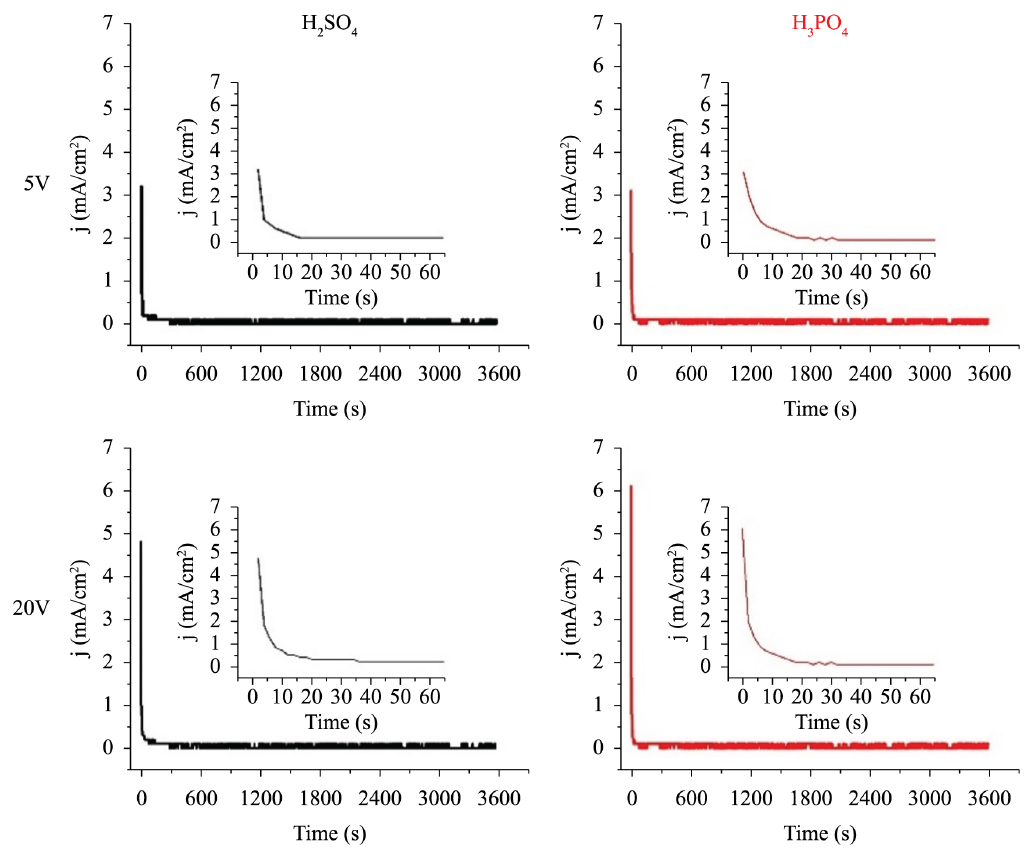
Figure 1. Chronoamperometric profiles for tantalum oxides obtaining at 5 V and 20 V in H the first seconds of the